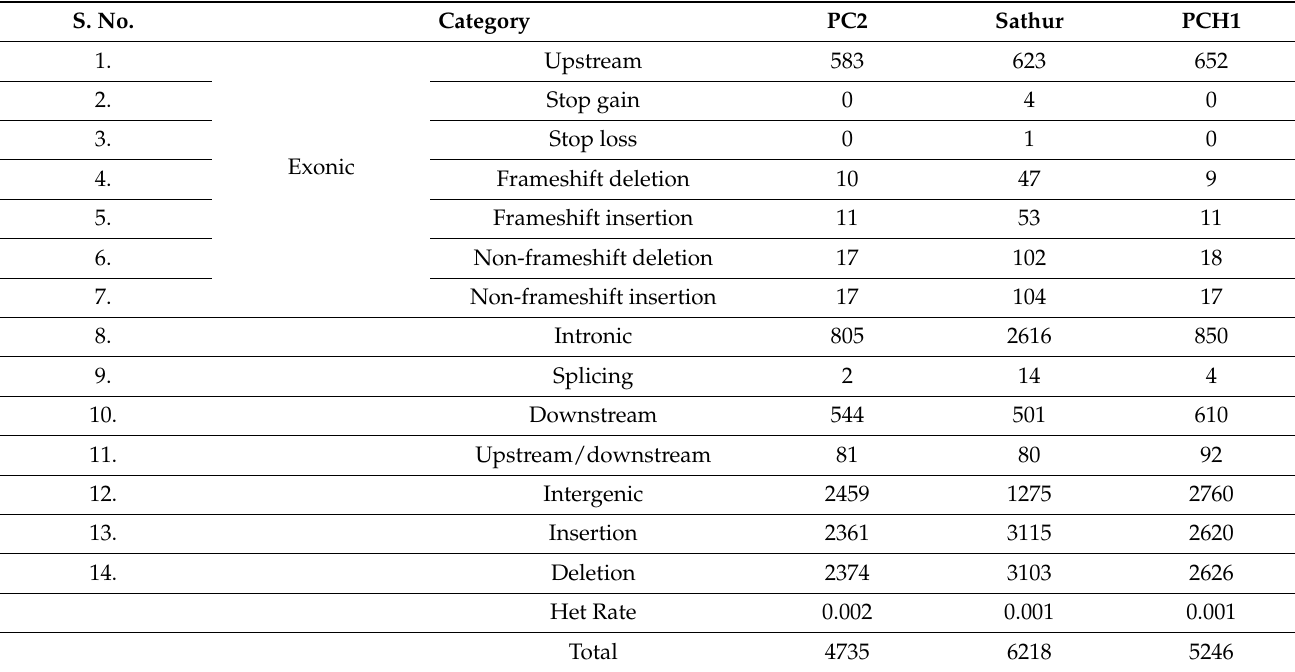
Table 7. Statistics of InDel detection and annotation. Descriptions of the categories are as that of Table